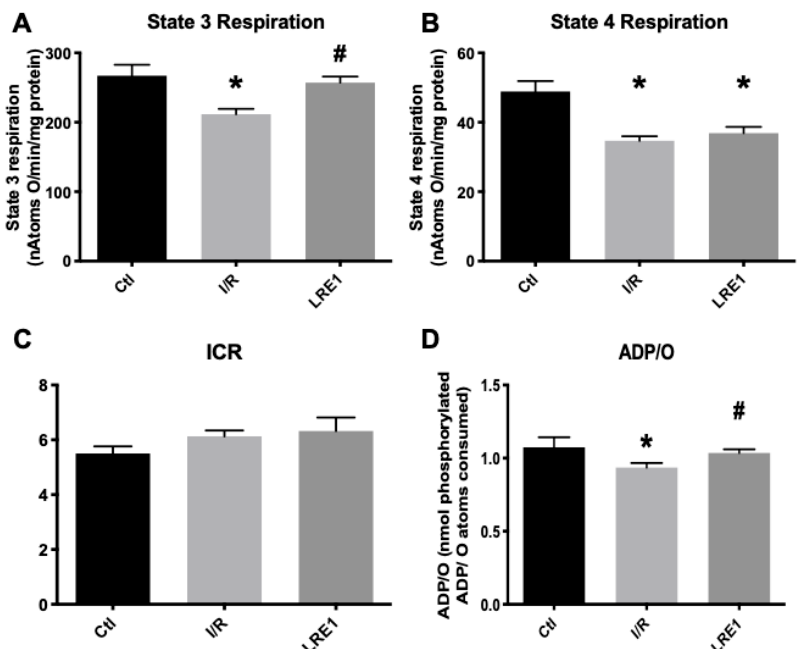
Figure 2. Mitochondrial oxygen consumption parameters (ADP-driven State 3 respiration, A ; repolarization respiration State 4, B ) and resulting ratios (Respiratory Control Index, ICR, C and; ADP / O, D ), as evaluated by O 2 consumption and recorded with a Clark-type electrode. Data are means ± SEM of 4 independent experiments. * indicates a statistically significant di ff erence vs. Ctl; # indicates a statistically significant di ff erence vs. I / R.